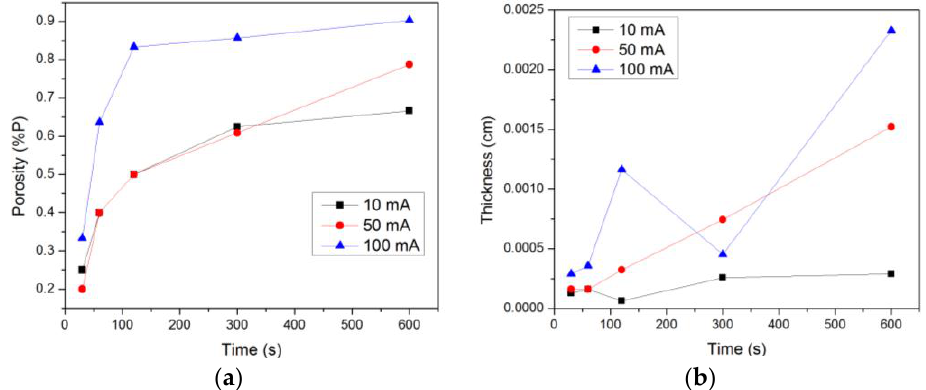
Figure 3. Plots of ( a ) Porosity percentage of PSi layers vs. anodizing time at different anodizing currents and ( b ) thickness vs. anodizing time.